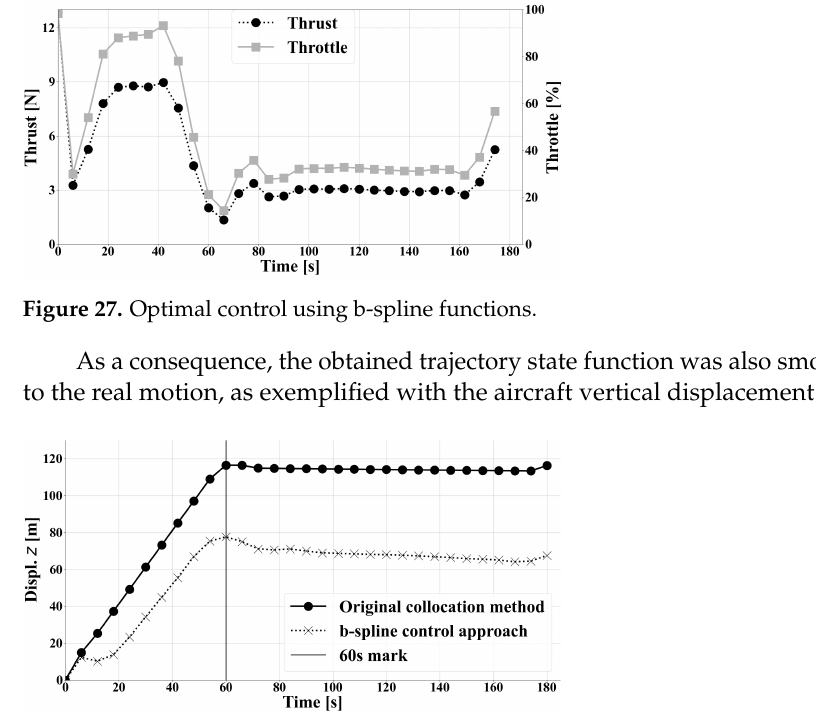
Figure 28. Optimal trajectory using b-spline control functions.